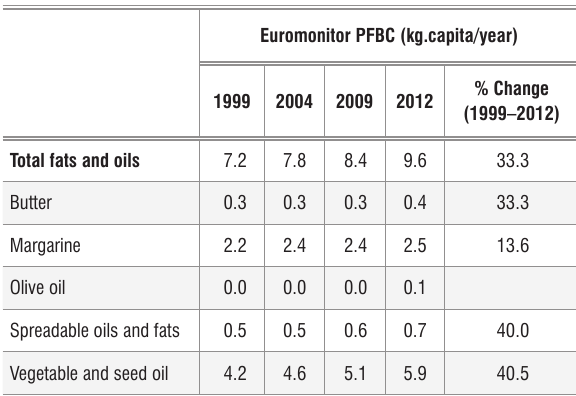
Consumption of packaged fats and oils in South